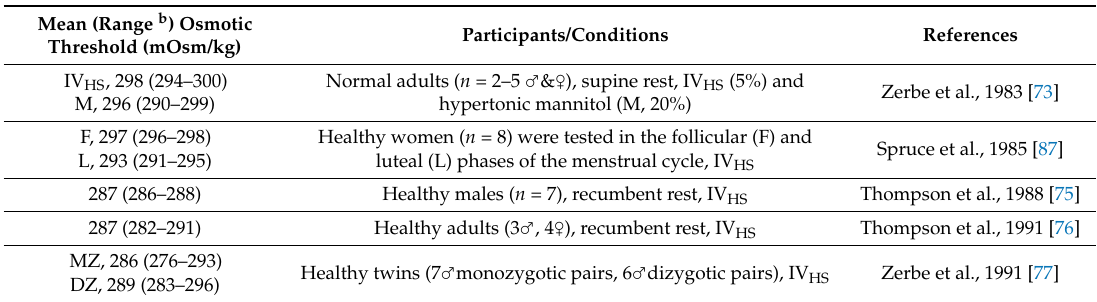
Table 6. Plasma osmotic threshold a for appearance of the thirst